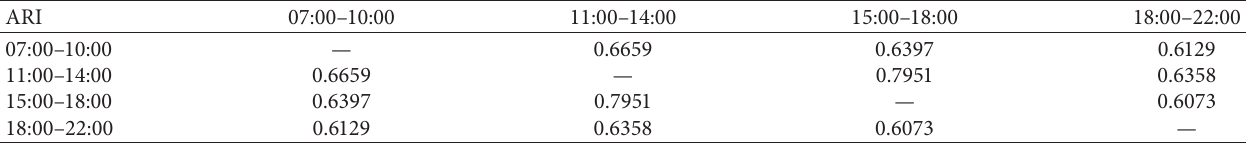
Table 3: The adjusted Rand index for different periods.